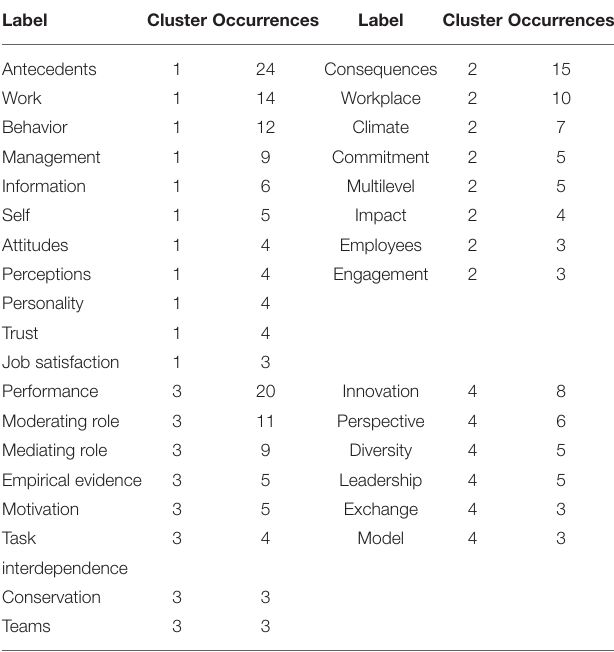
TABLE 1 | Clustering analysis of knowledge hiding literature (Clusters